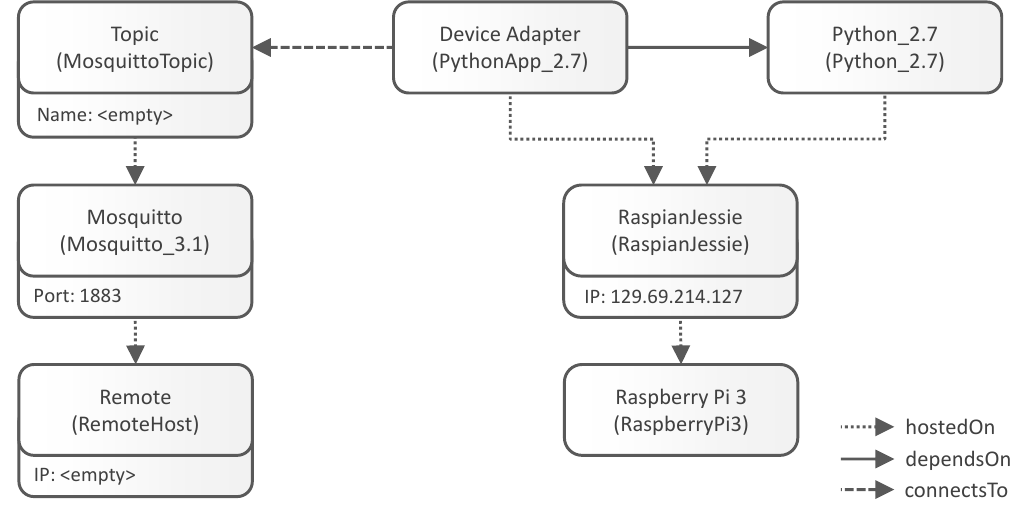
Figure 5. TOSCA topology for Python device adapters connecting to a MQTT Mosquitto broker